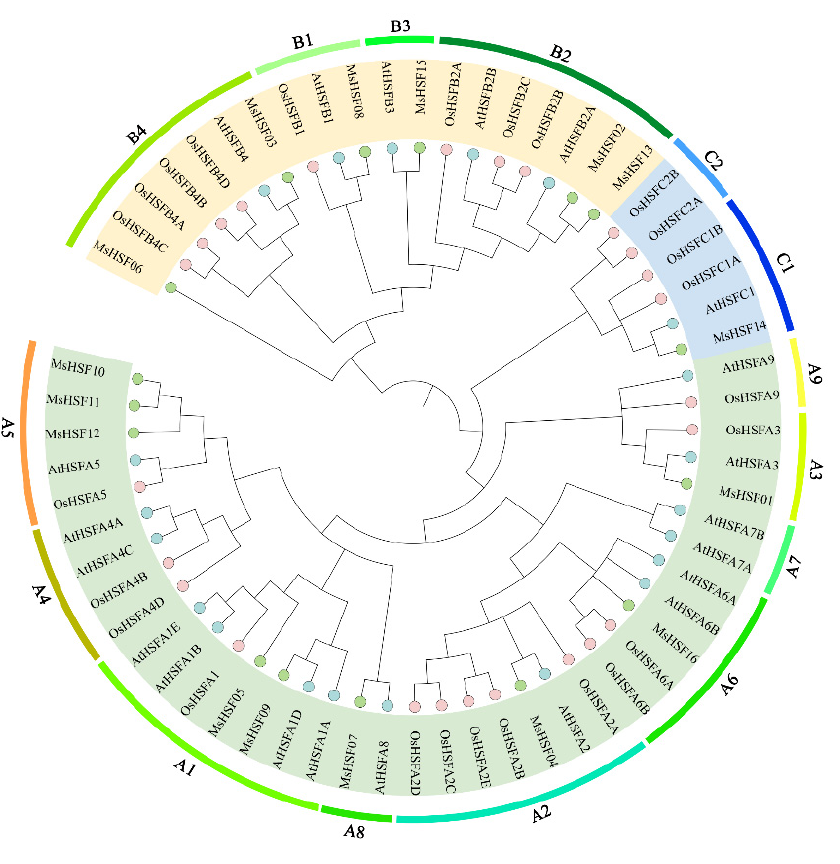
Figure 1. Model for phylogenetic analysis of HSF in M. sativa . Each subgroup is distinguished by a different color.